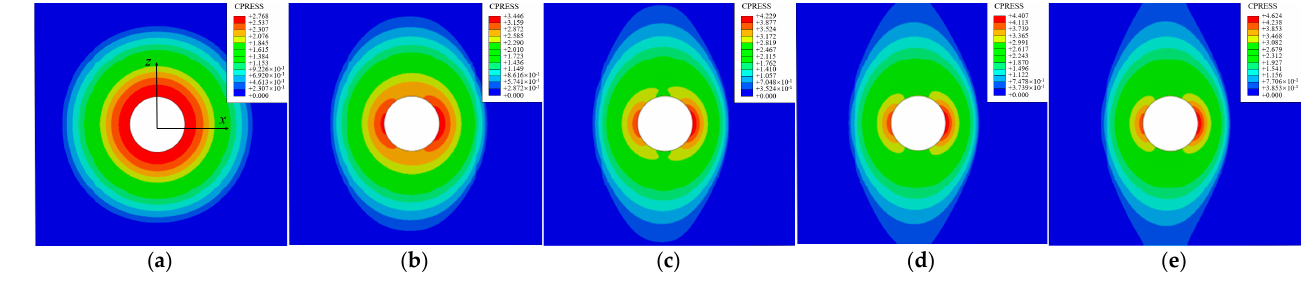
Figure 21. Pressure distribution on the inter-plate surface under mixed-mode loading: ( a ) T = 0 N, ( b ) T = 228.555 N, ( c ) T = 489.332 N, ( d ) T = 575.232 N, ( e ) T = 632.458 N.